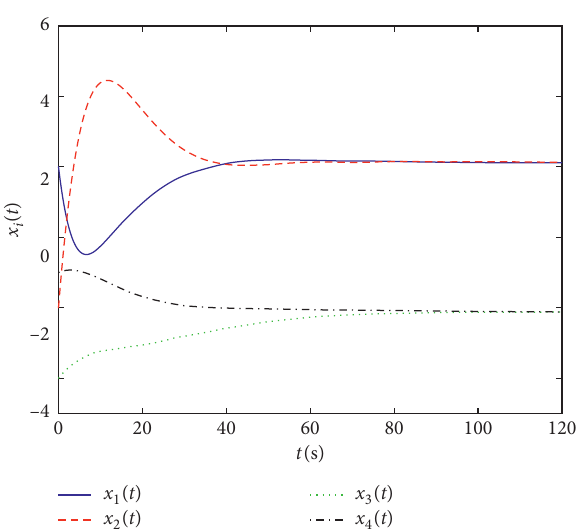
Figure 8: The position trajectory of each agent when τ �